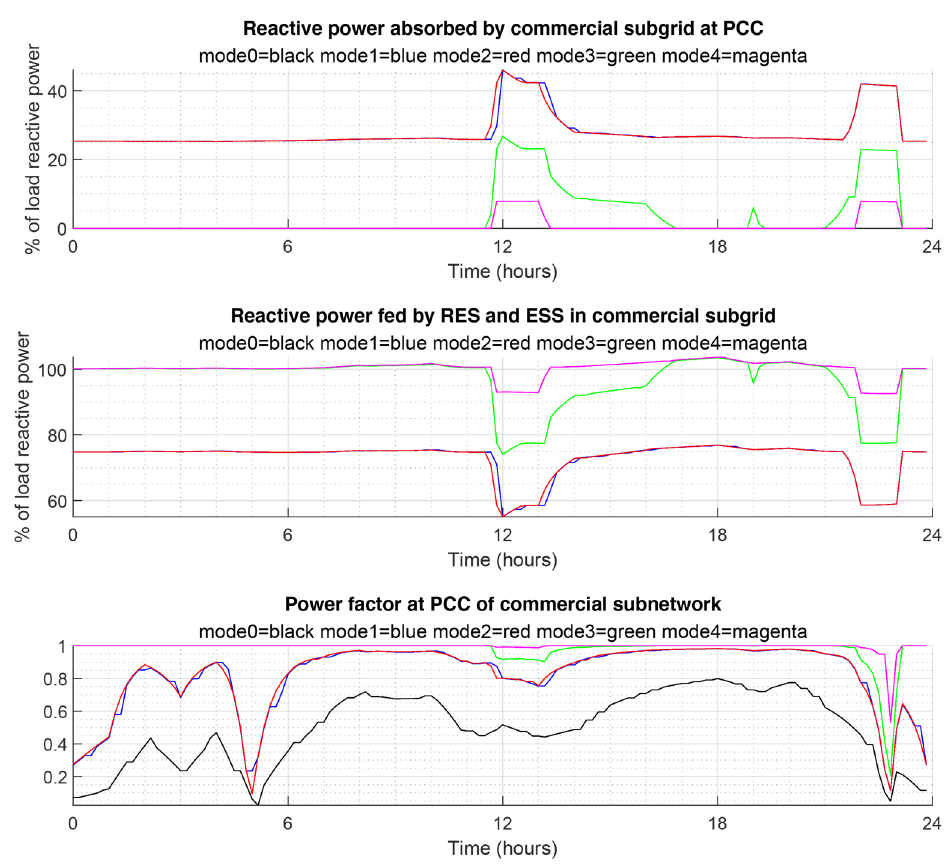
Figure 5. Effect of control methods on the power factor at the PCC.